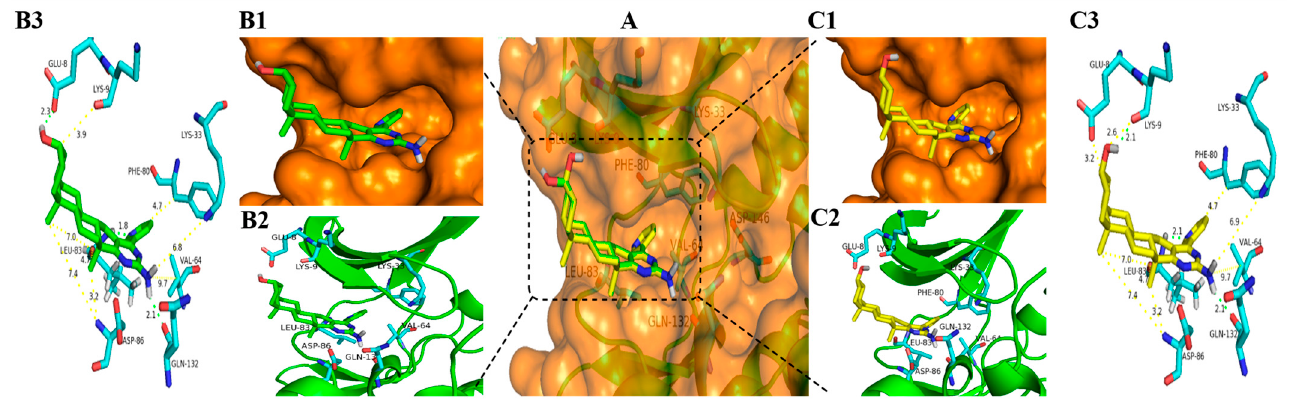
Figure 8. Docking modes of 3l and 6l with CDK1 (PDB code: 6GU6). ( A ) Overview of the binding site of 3l (green stick) and 6l (yellow stick) with CDK1 (orange transparent surface structure fused with a sticks structure of white hydrogen atoms, cyan carbon atoms, blue nitrogen atoms, and red oxygen atoms); ( B1 ) Position of 3l in the orange surface structure of CDK1; ( B2 ) Position of 3l in cartoon structure of CDK1; ( B3 ) Binding model for 3l bond to CDK1 (Hydrogen bonds are drawn as green dashed lines with distances labelled in Å while the yellow dashed lines just display the distance between the atoms); ( C1 ) Position of 6l in the orange surface structure of CDK1; ( C2 ) Position of 6l in cartoon structure of CDK1; ( C3 ) Binding model for 6l bond to CDK1 (Hydrogen bonds are drawn as green dashed lines with distances labelled in Å while the yellow dashed lines just display the distance between the atoms). Figures were drawn with Pymol (Schrödinger).